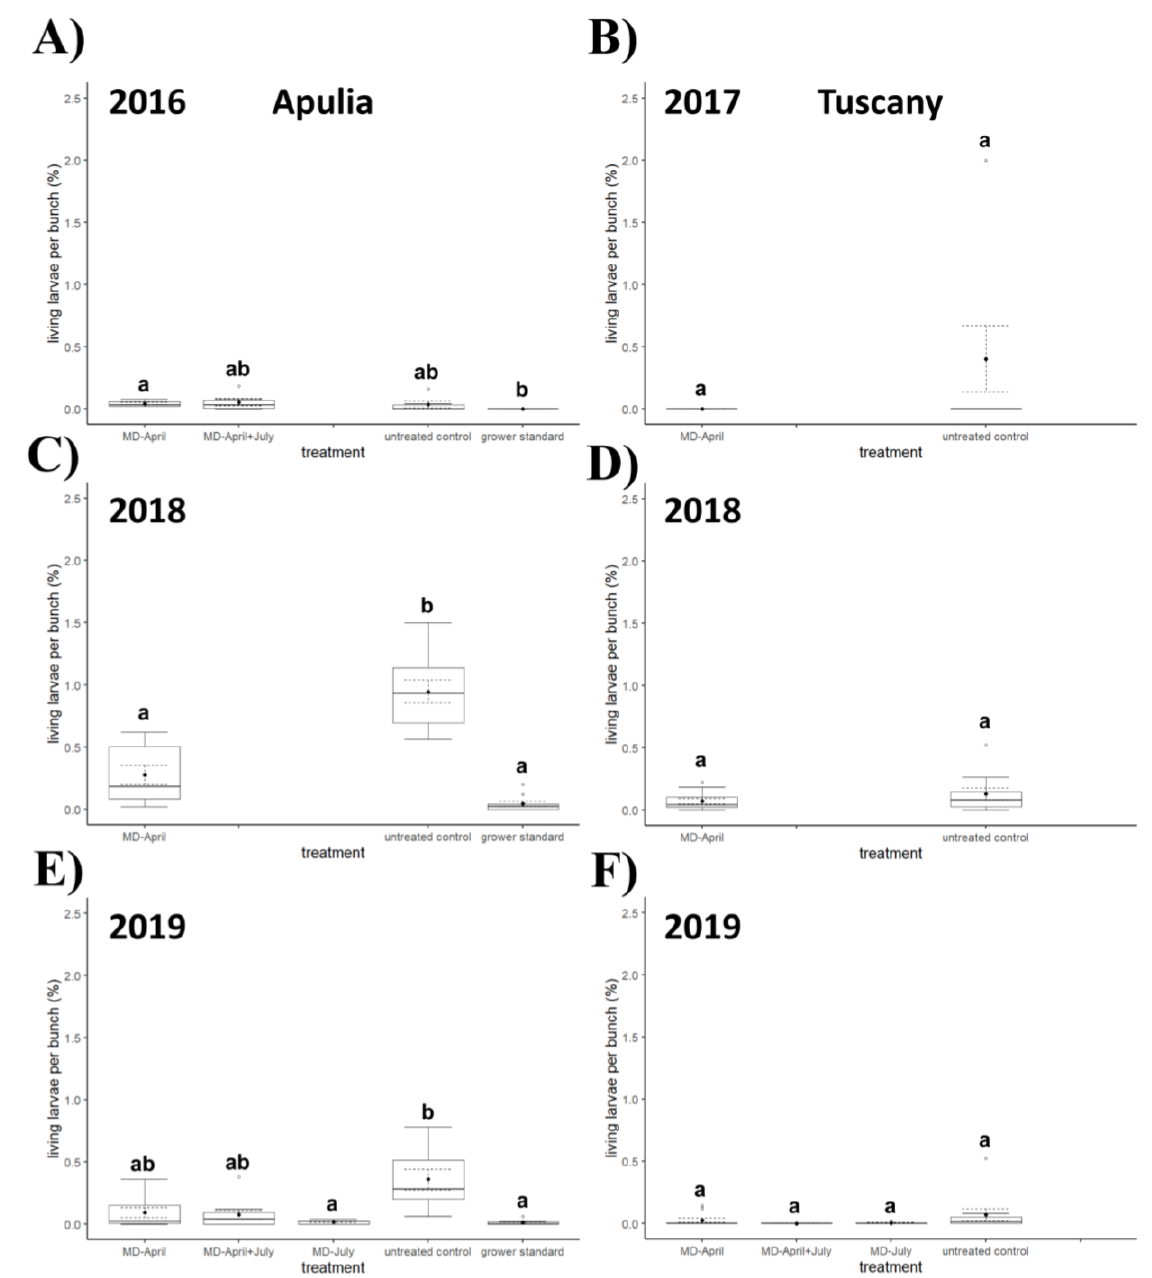
Figure 6. Impact of mating disruption (MD) using Isonet CGX111 dispensers on number of living larvae of Cryptoblabes gnidiella per bunch among treatments and untreated control plots in Apulia ( A , C , E ) and Tuscany ( B , D , F ) during three-year samplings. Boxplots indicate the median (solid line) and the range of dispersion (lower and upper quartiles and outliers) of the parameter; black dot and dashed line indicate mean value and standard error, respectively. Different letters above boxplots indicate significant differences among treatments (Wilcoxon test for comparisons between two plots or Kruskal–Wallis test for multiple comparisons, the latter followed by Nemenyi post hoc test; p < 0.05).